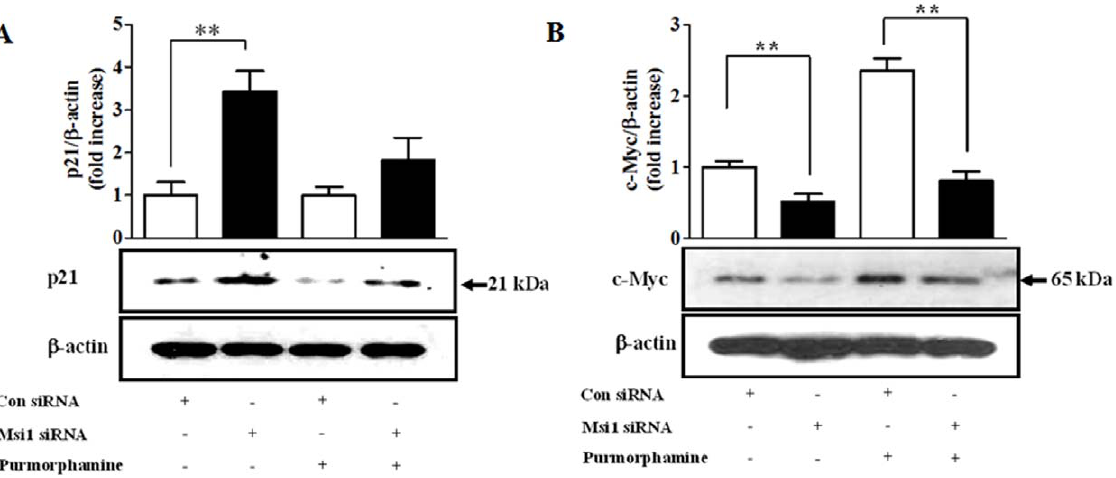
Figure 6. The effects of purmorphamine on p21 CIP1,WAF1 and c-Myc are mediated through Msi1. hUCB-MSCs were first transfected with 50 nM Msi1 siRNA for 48 h and then treated with or without purmorphamine (4 m M) for 3 days. The transfection of 50 nM Msi1 siRNA reversed the inhibitory ( A ) and stimulatory ( B ) effects of purmorphamine on p21 CIP1,WAF1 and c-Myc expression, respectively. b -actin was used as an internal control. The results are shown as the mean 6 SD from three independent experiments. * P , 0.05, ** P , 0.01, and *** P , 0.001.